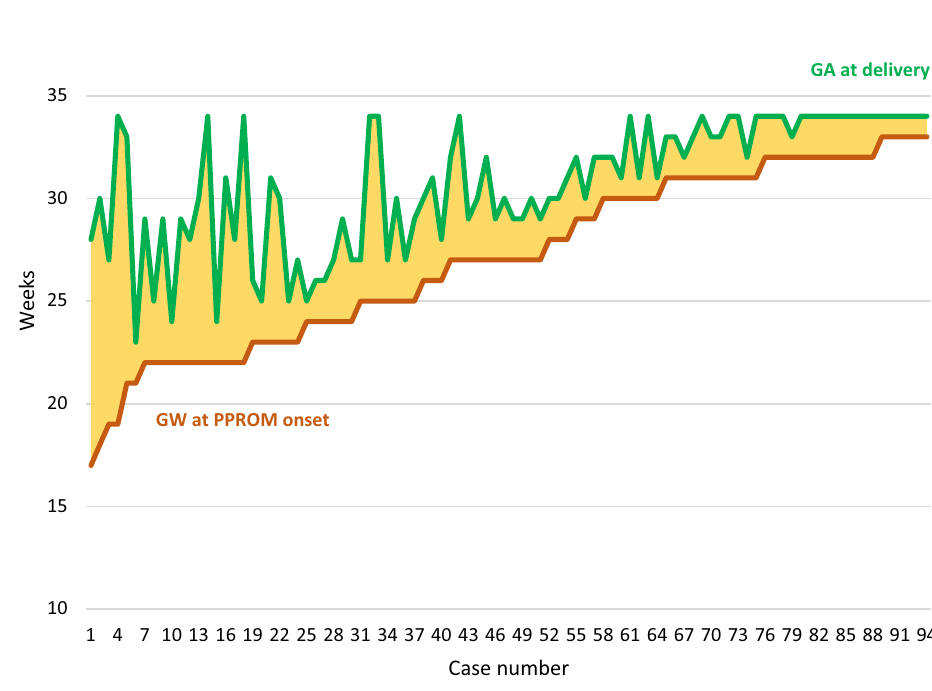
Figure 2. Gestational Age (GA) at delivery by gestation week (GW) at